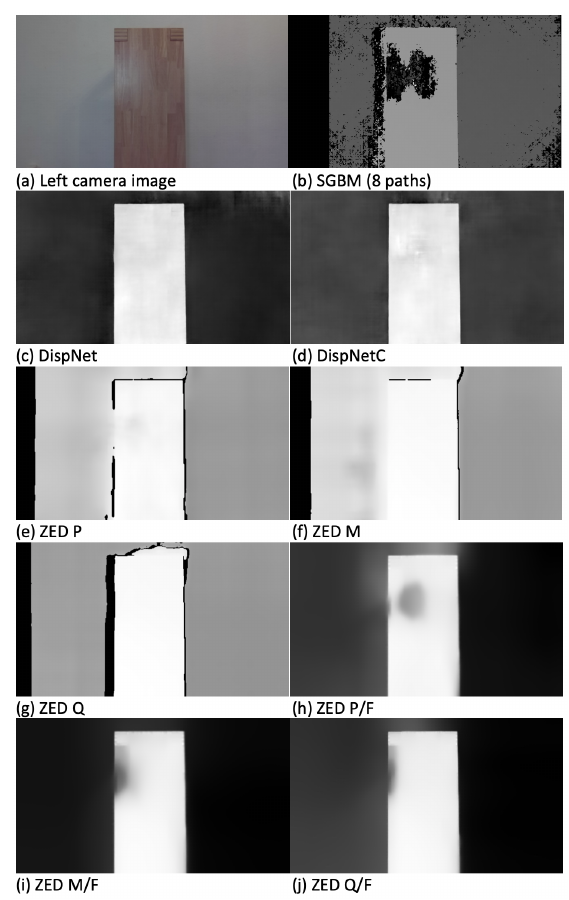
Figure 5. Edge at 0.7m distance. The ”P” ”M” and ”Q” options are quality options of the ZED system, with increasing reconstruction quality. The ”F” option is for filling gaps.